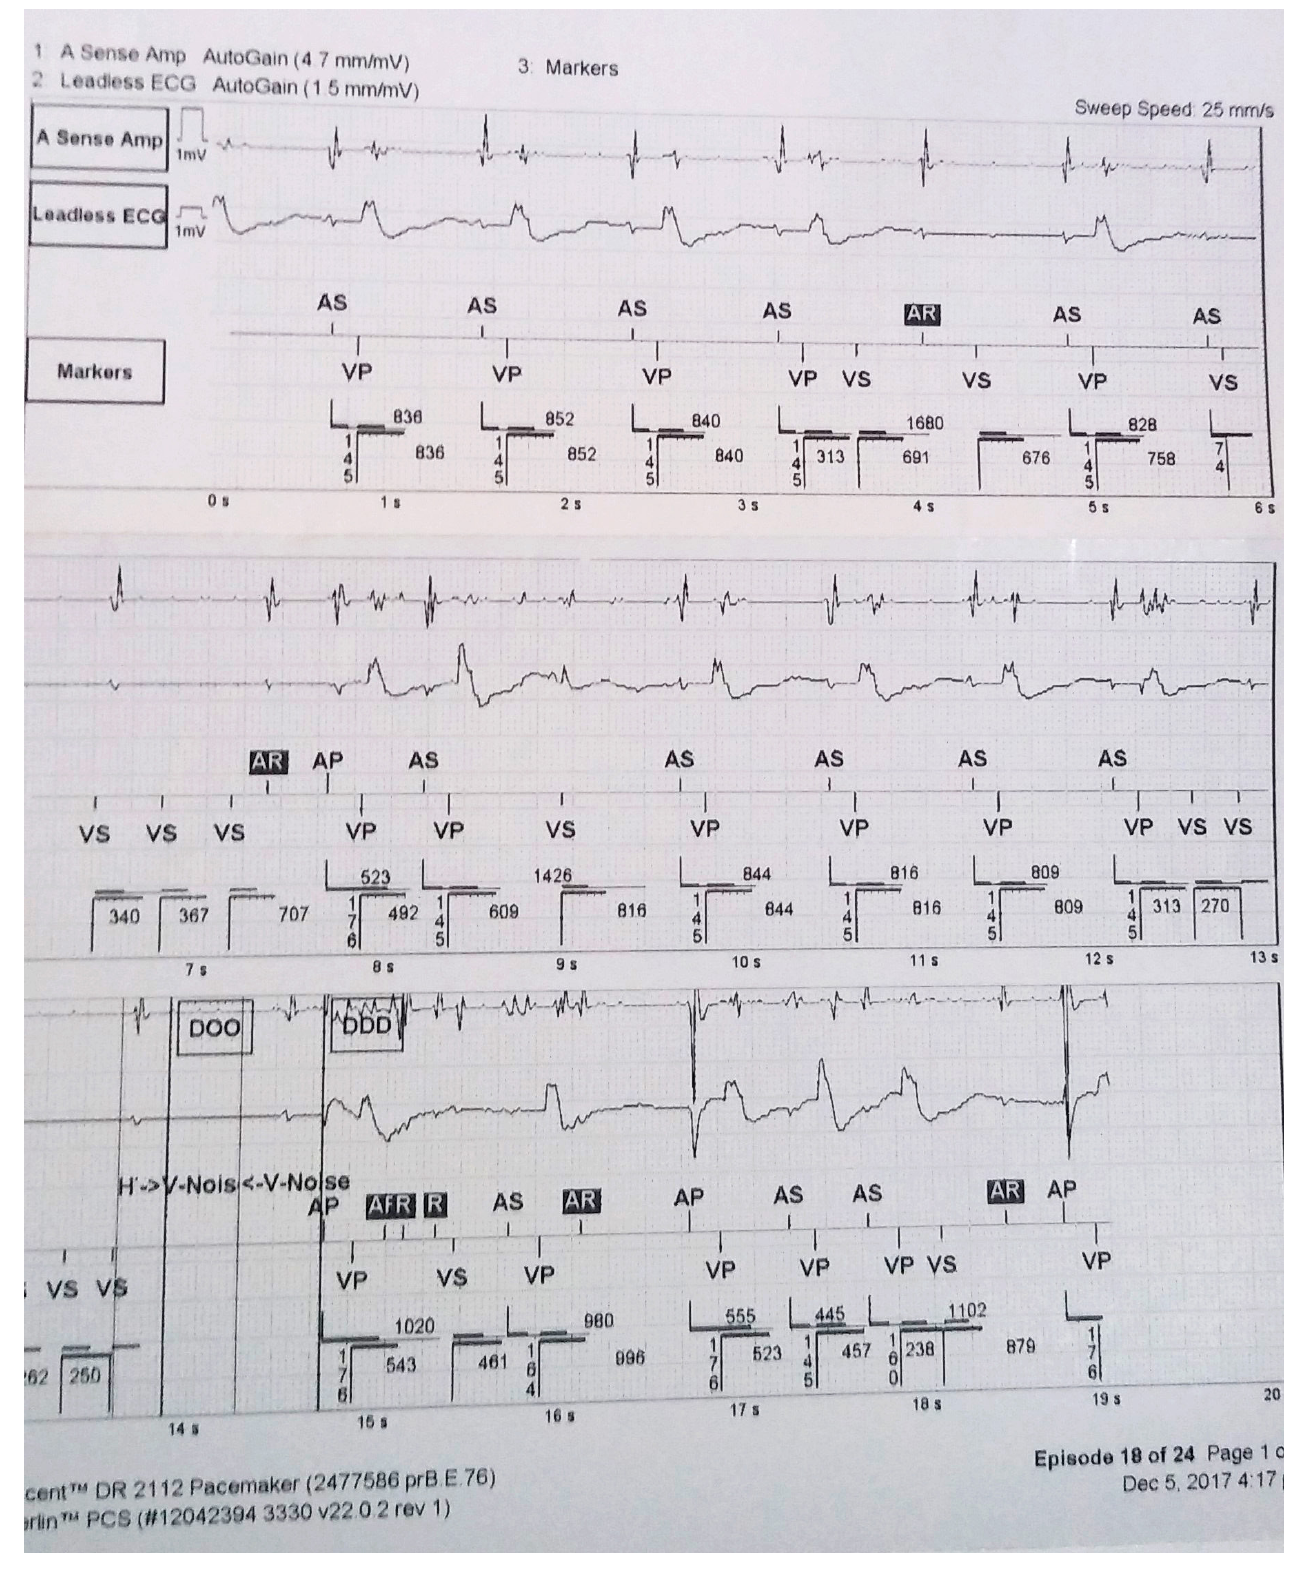
Fig. 1 – Incomplete electrode fracture. Pauses due to inhibitions of ventricular stimulation.